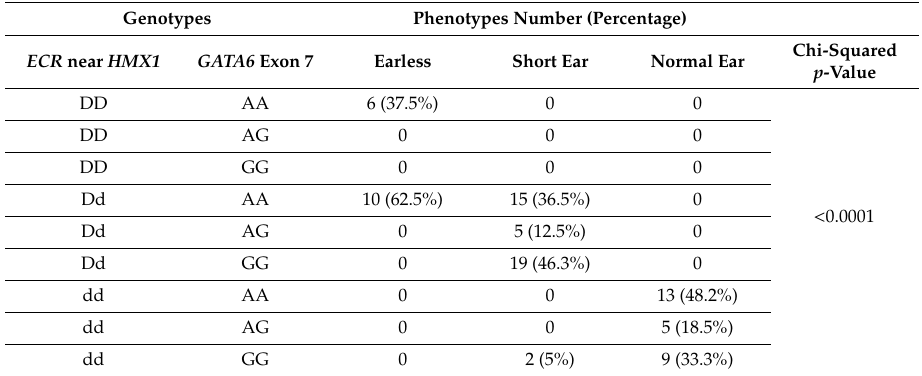
Table 3. Interaction between mutation at GATA6 gene Exon 7 ((wild type AA), AG and GG) and evolutionary conserved region ( ECR ) near to HMX1 gene product size (DD: 591 bp, Dd: 515 + 591 bp and dd: 515 bp (wild type)) and its association with ear types in Awassi sheep.